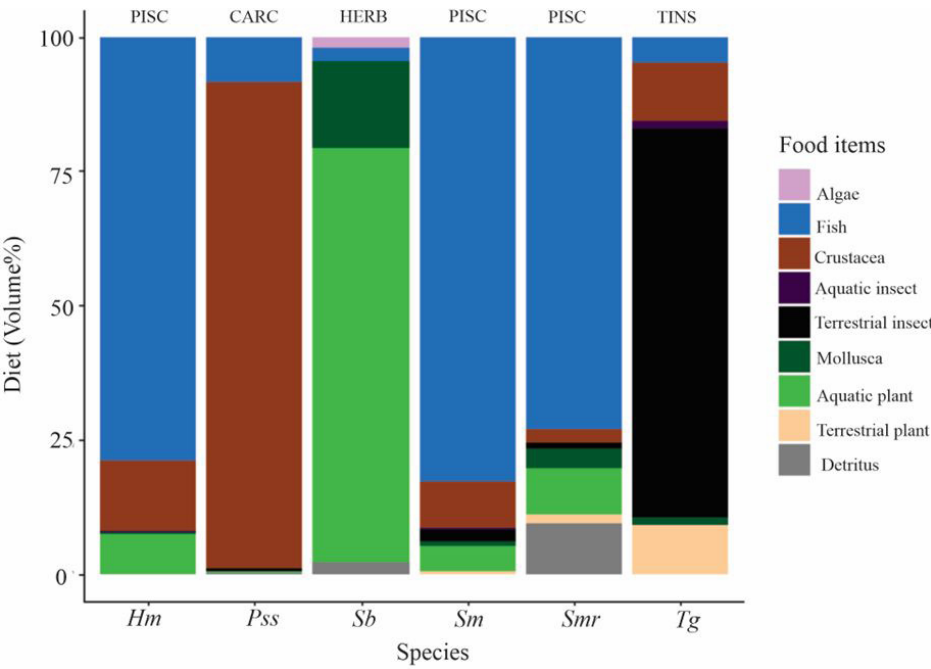
Figure 2. Volume percentage (%) of food items consumed by fish species and their trophic guild in the Refúgio Biológico de Santa Helena, Itaipu Reservoir, Paraná III River Basin, Brazil. Hoplias malabaricus ( Hm ), Plagioscion squamosissimus ( Pss ), Schizodon borellii ( Sb ), Serrasalmus maculatus ( Sm ), Serrasalmus marginatus ( Smr ), Trachelyopterus galeatus ( Tg ), PISC = Piscivore, CARC = Carcinofage, HERB = Herbivore, TINS = Terrestrial